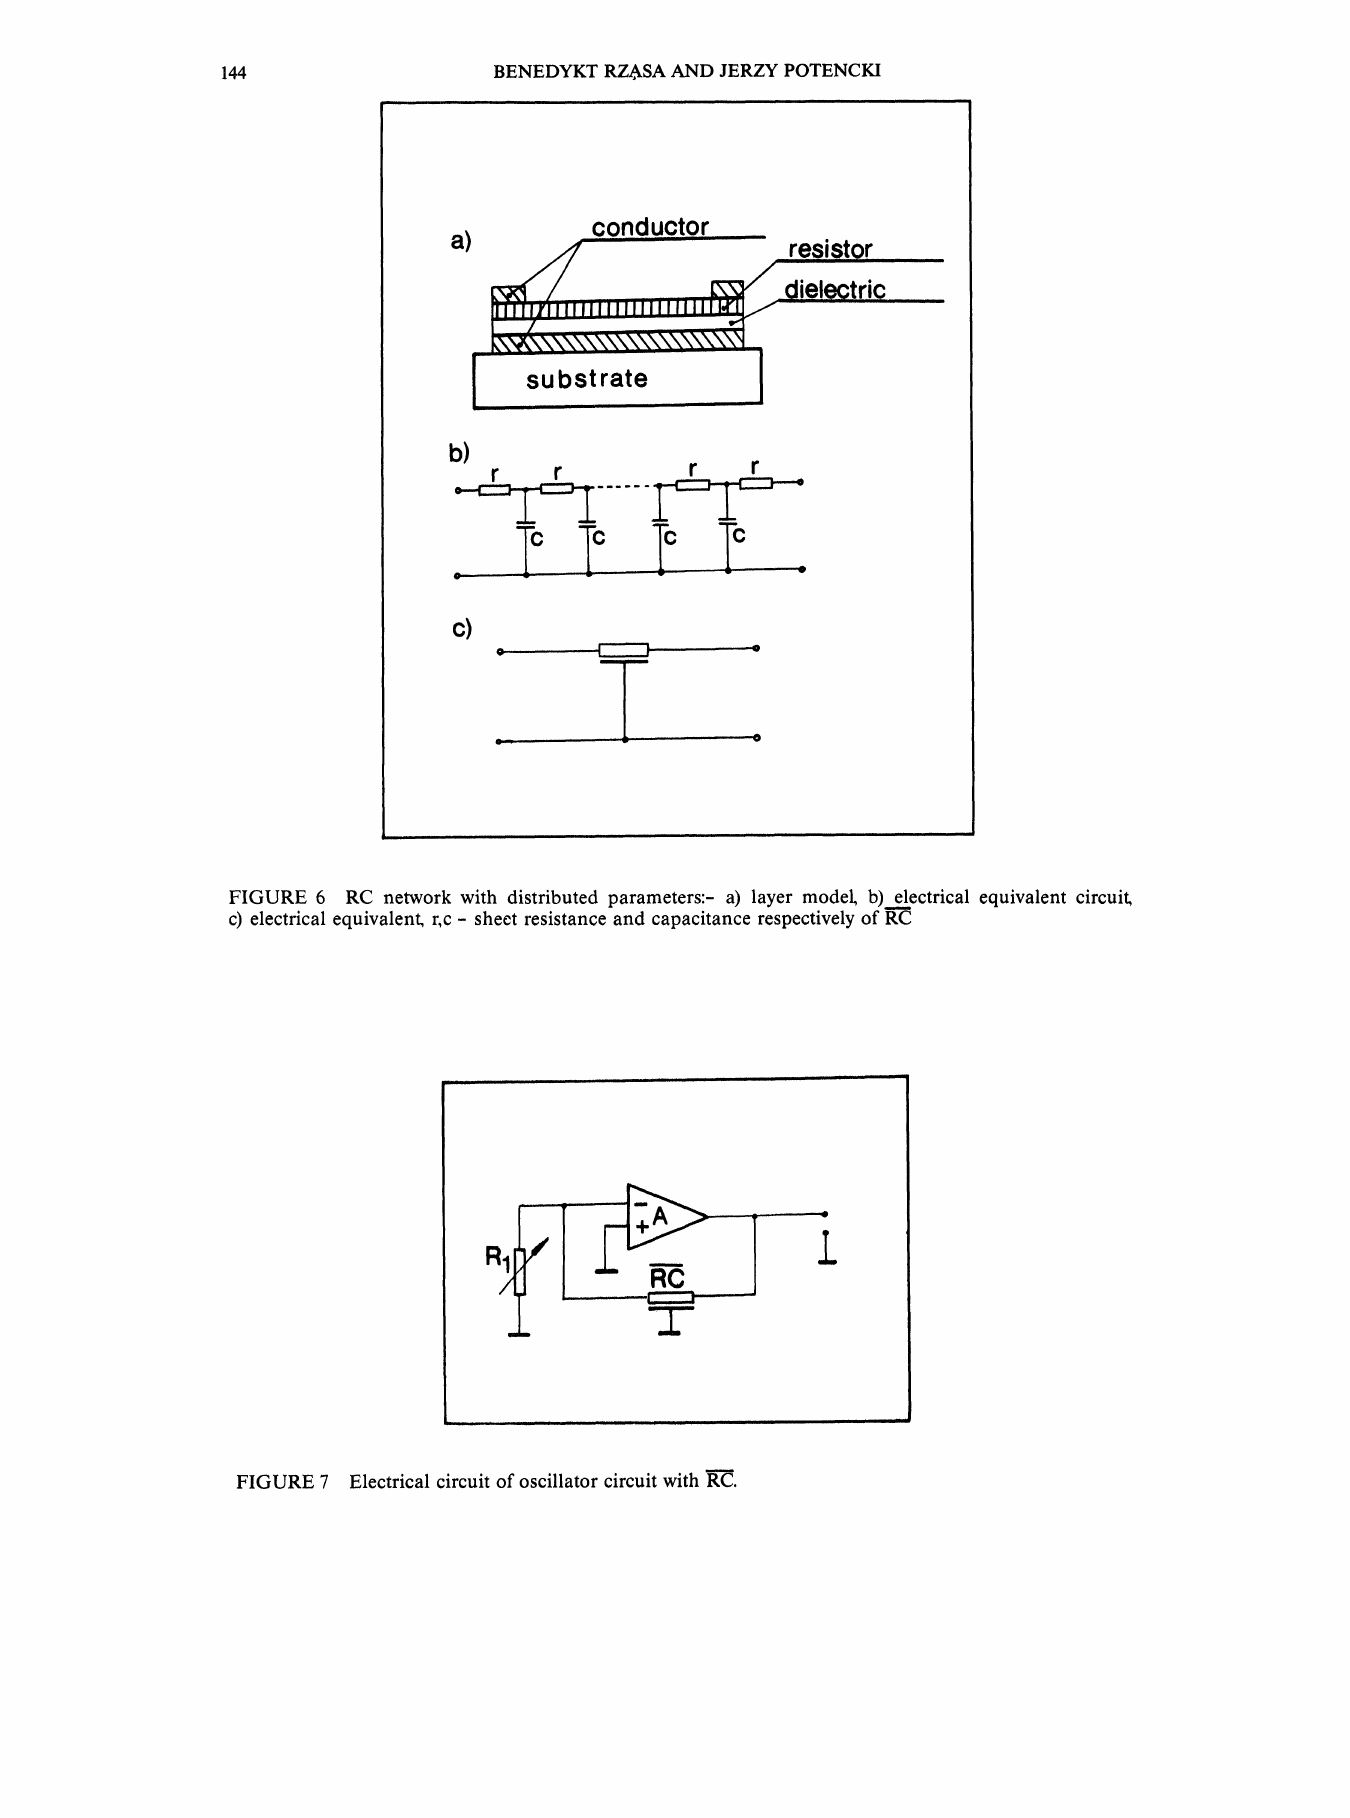
FIGURE 7 Electrical circuit of oscillator circuit with